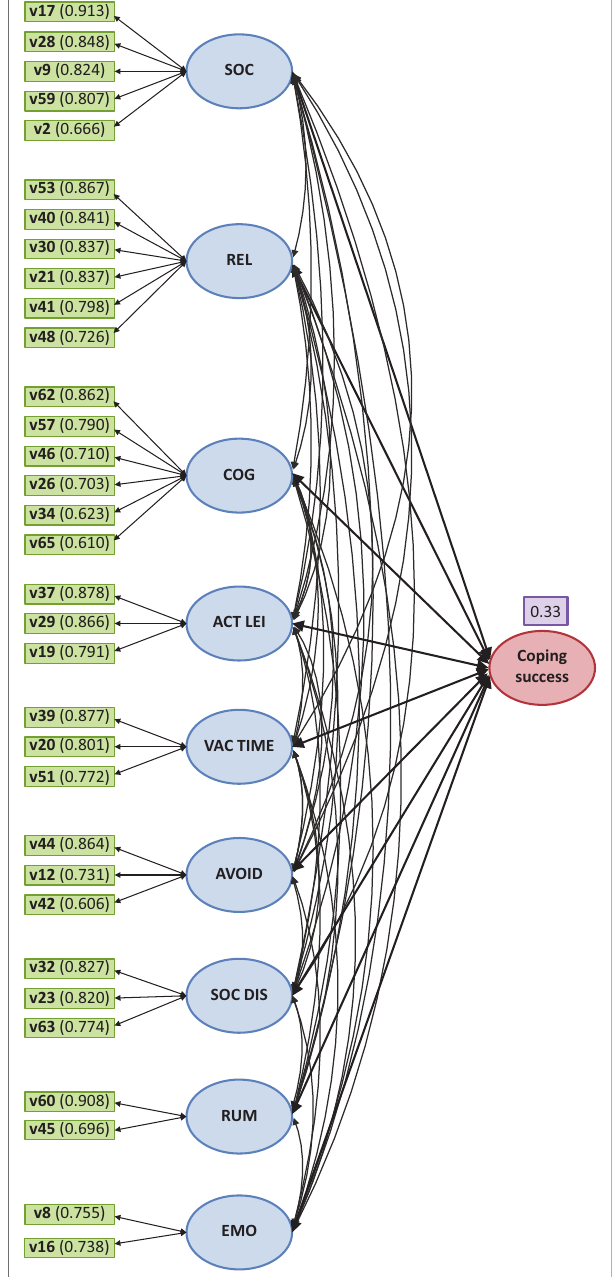
FIGURE 2: Structured equation